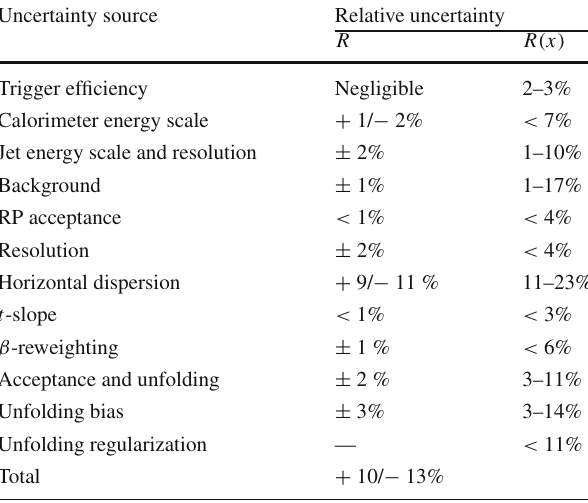
Table 3 Individual contributions to the systematic uncertainty in the measurement of the single-diffractive to inclusive dijet yields ratio in the kinematic region p T > 40GeV, | η | < 4 . 4, ξ < 0 . 1, 0 . 03 < | t | < 1GeV 2 , and − 2 . 9 ≤ log 10 x ≤ − 1 . 6. The second and third columns represent the relative uncertainties in the ratio in the full kinematic region and in bins of log 10 x , respectively. The minimum relative uncer- tainty is not shown when it is below 1%. The total uncertainty is the quadratic sum of the individual contributions